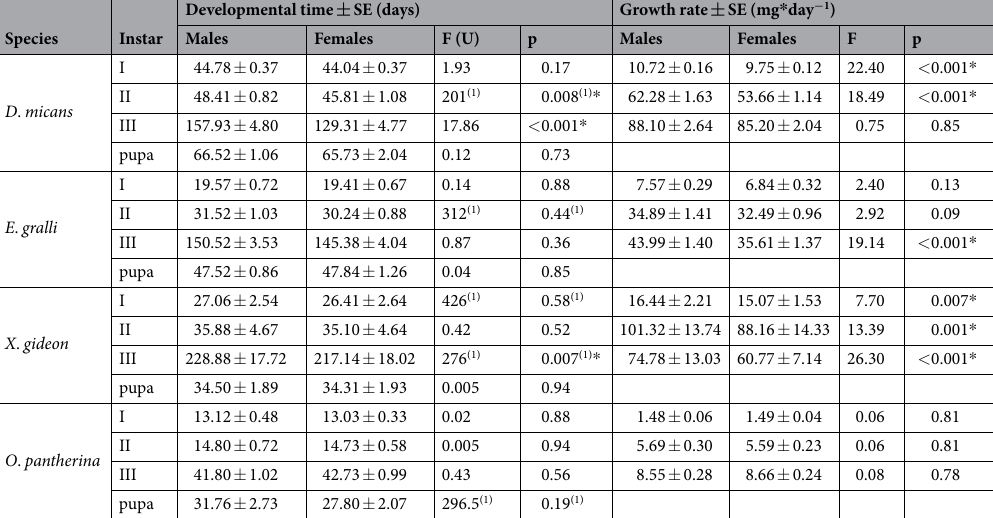
Table 3. Developmental times and average growth rates in particular instars and sexes in four scarab species. Differences between sexes were tested with a one-way ANOVA and Mann-Whitney U-test in the case of non- normal distributed data. (1) Tested by nonparametric Mann-Whitney